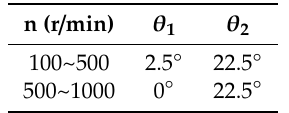
Table 1. θ 1 and θ 2 at the di ff erent rotor speed